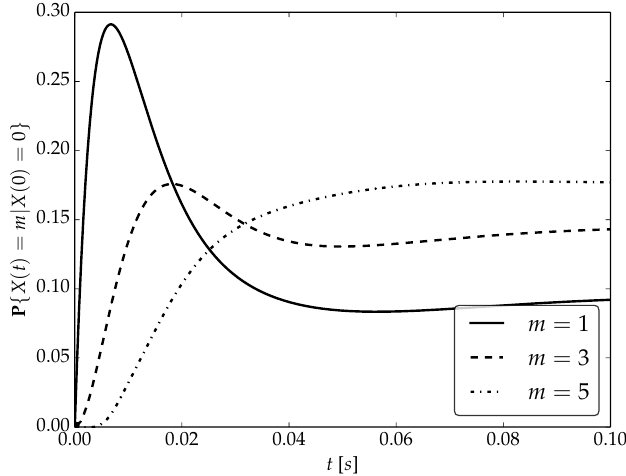
for P 1 , ρ = 1 and mean setup time X ( t ) = m X ( 0 ) = 0 { | }